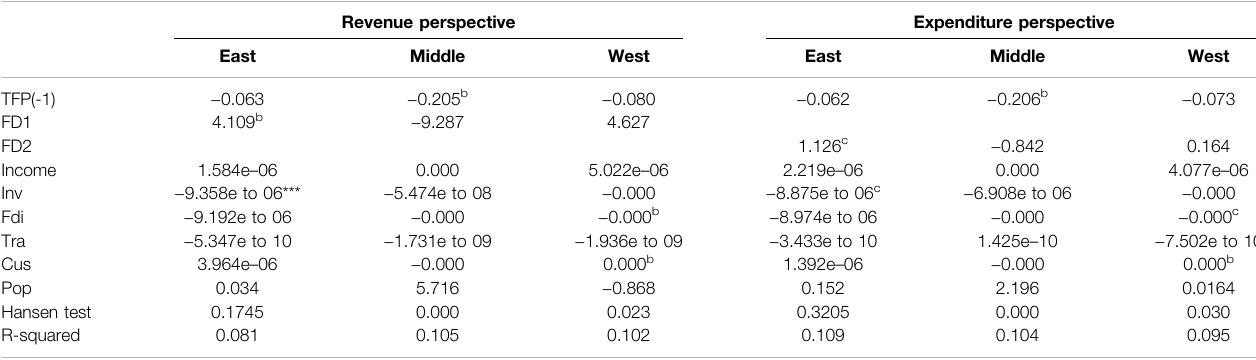
TABLE 6 | Robustness testing and endogenous problem